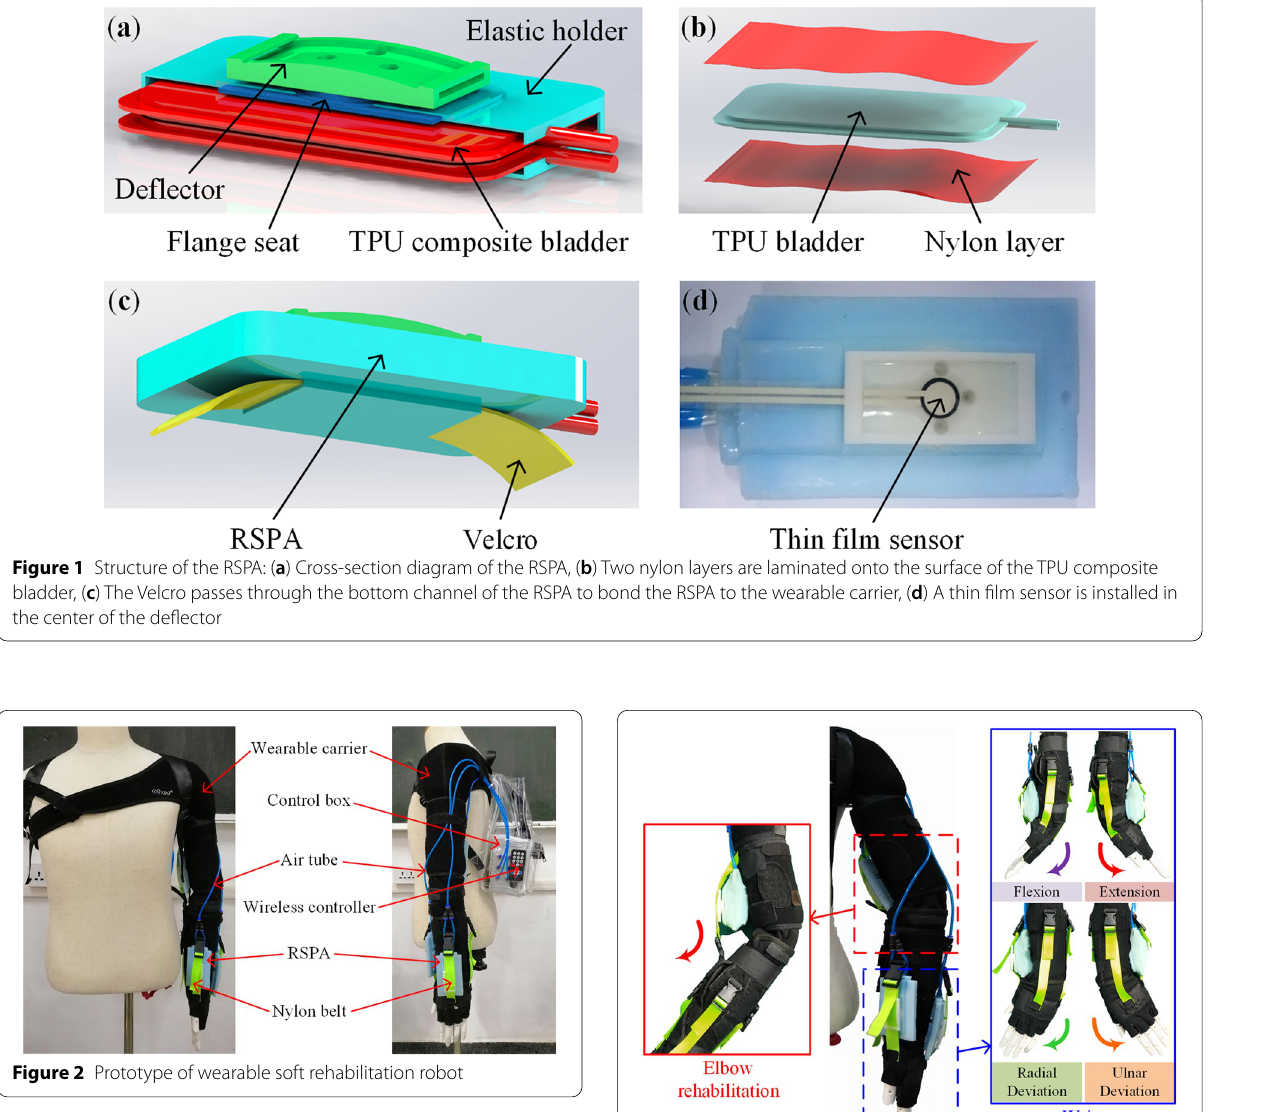
pipelines. The control strategy of each joint reha- action and force policy, which has the advantages of